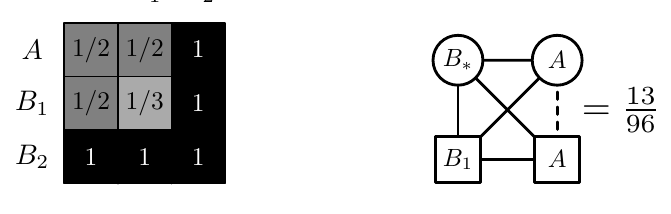
Figure 2: An example of evaluating a decorated